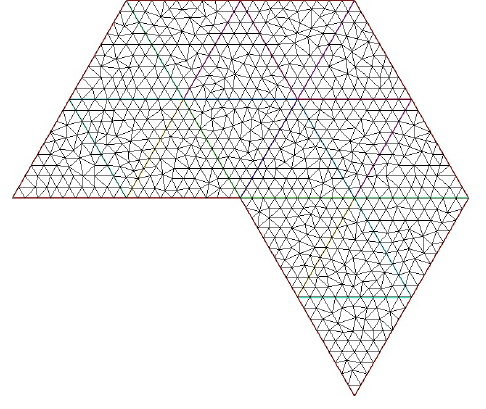
Figure 2. “Normal”